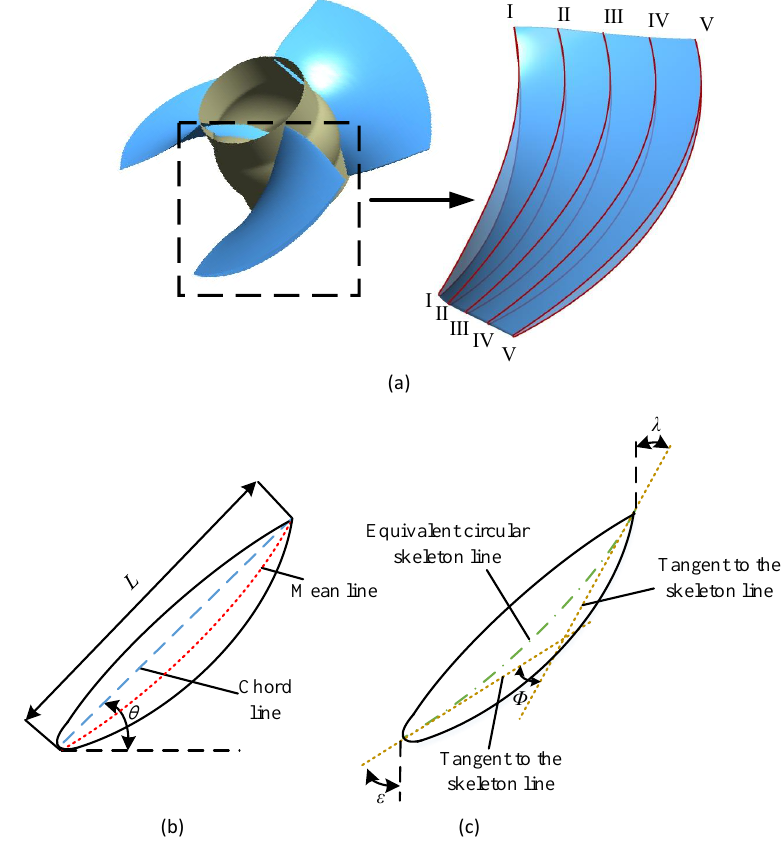
Figure 6. The definition of the main geometry variables of the impeller: ( a ) definition of the airfoil section, ( b ) main geometry variables of the airfoil and ( c ) the rest of the geometry